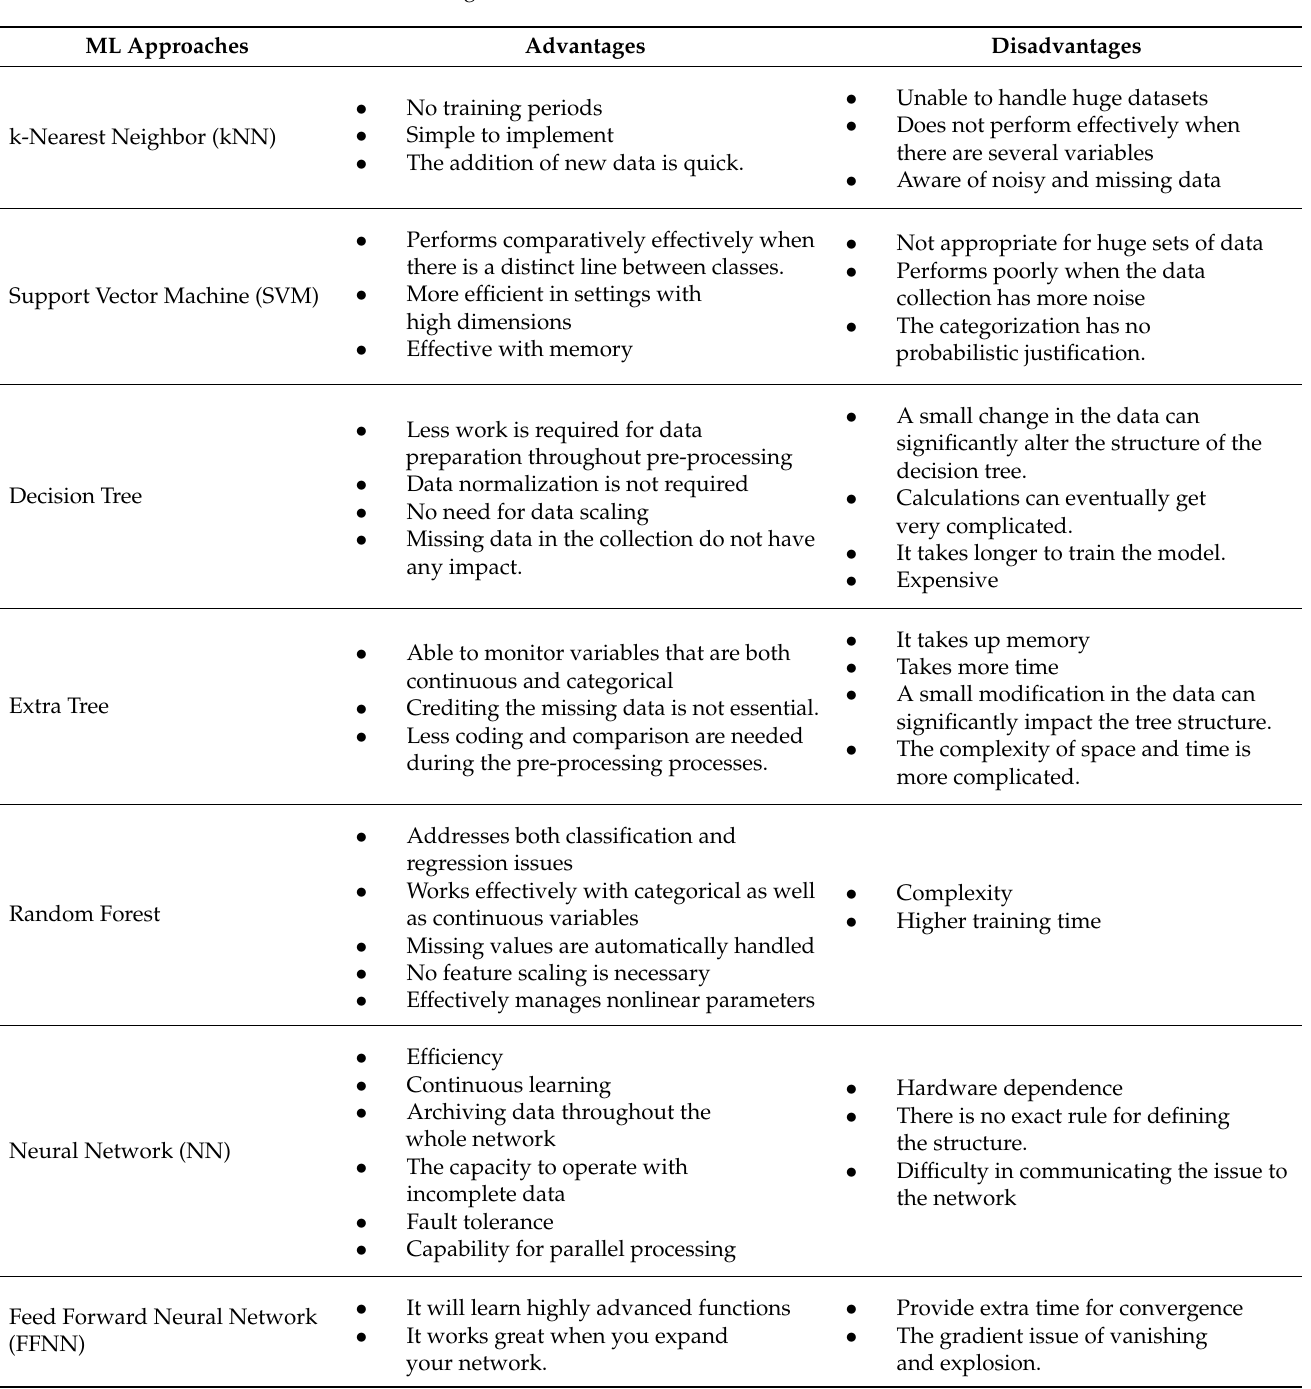
Table 2. ML algorithms used for UAV indoor